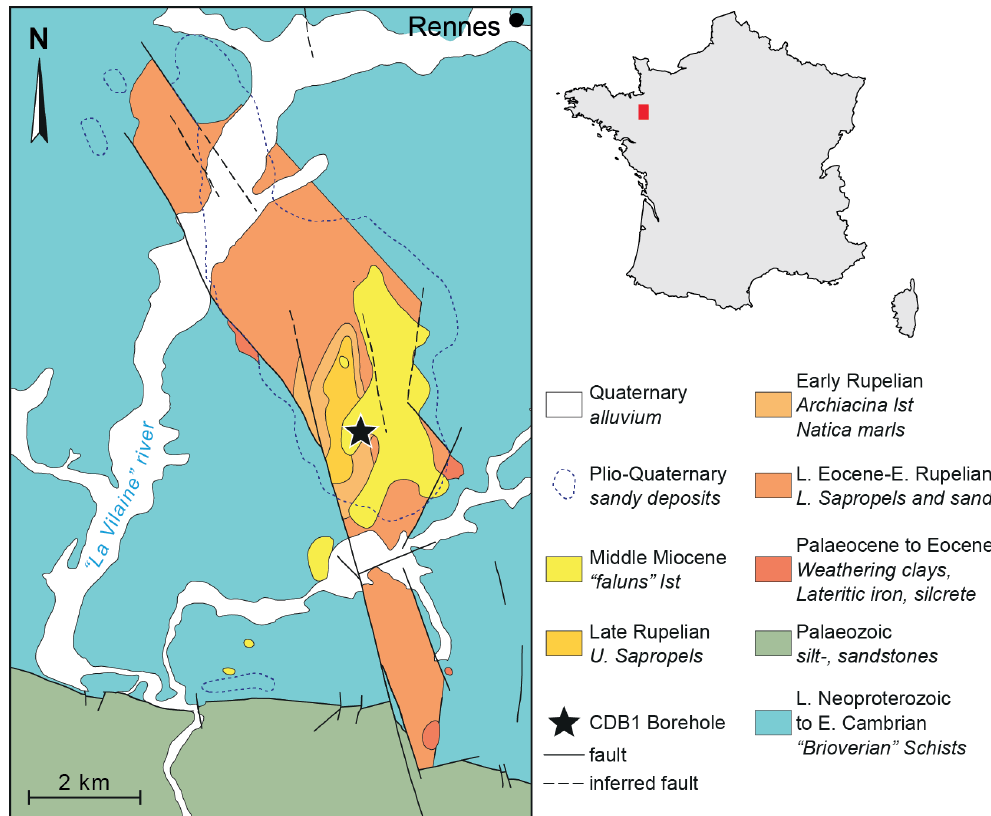
Figure 1. Geographic and geologic location of CDB1 drill core in the Rennes Basin (NW France, modified from Bauer et al.,